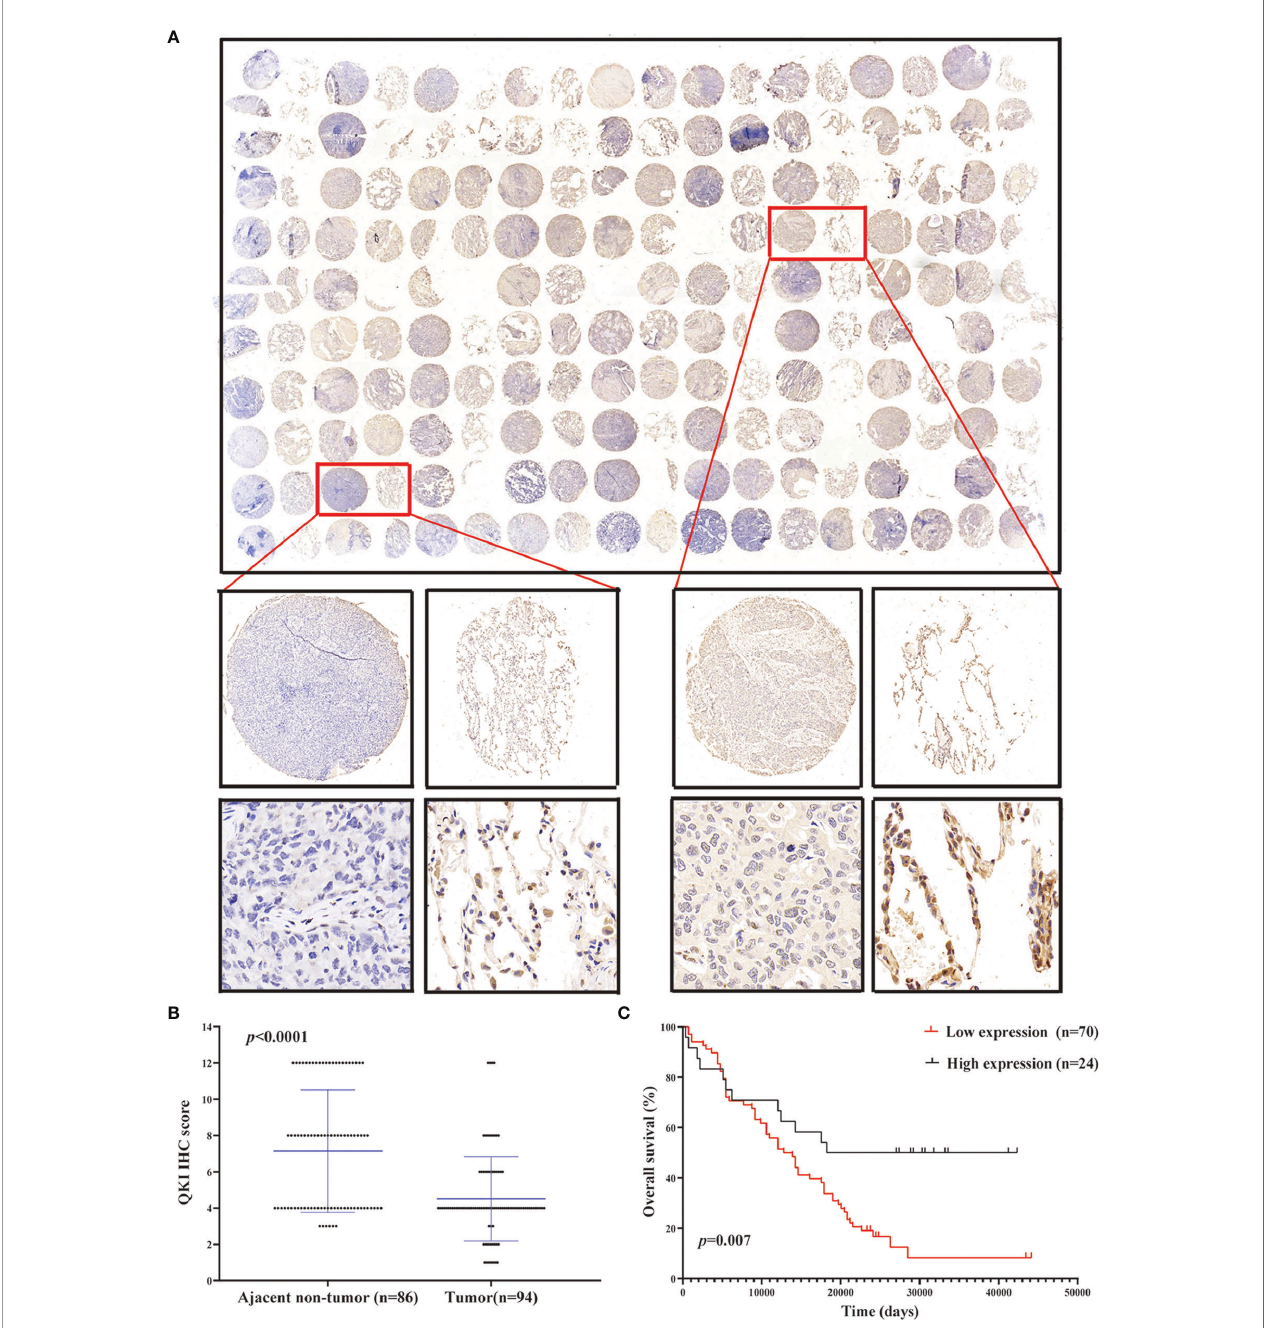
FIGURE 2 | QKI downregulation in human NSCLC tissues. (A) Representative images of tumor and peritumor tissues after QKI staining. Scale bar, 200 and 50 m m (inset), respectively. (B) QKI expression was lower in tumor tissue than in ajacent non-tumor tissue ( P < 0.0001). (C) KM plotter survival analysis based on microarray tissue IHC (immunohistochemistry) results containing 74 patients with NSCLC (low expression vs. high expression; HR = 2.24, 95% CI = 1.35 – 3.71, P = 0.007, log- rank